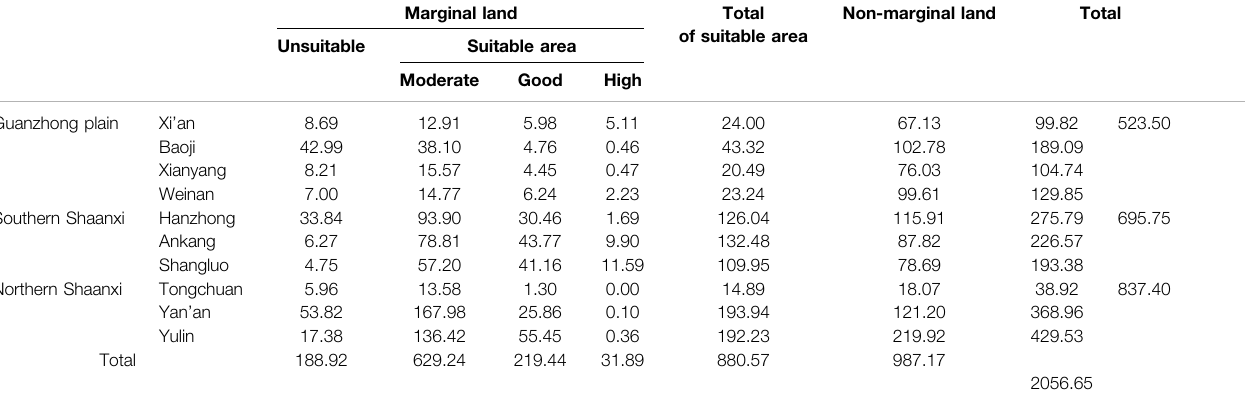
TABLE 3 | Statistical results of classi fi cation of marginal lands suitable for planting Jerusalem artichoke in Shaanxi Province with the unit 1.00 × 10 8 m 2 . Marginal land Total of suitable